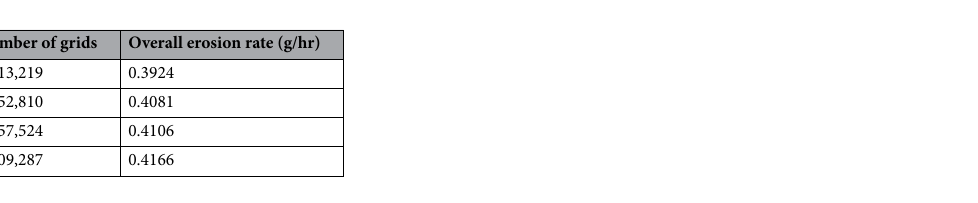
Table 3. Mesh refinement